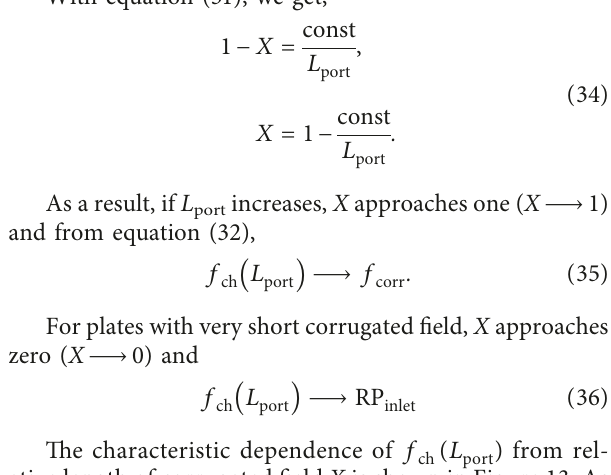
corr vs. Reynolds number for